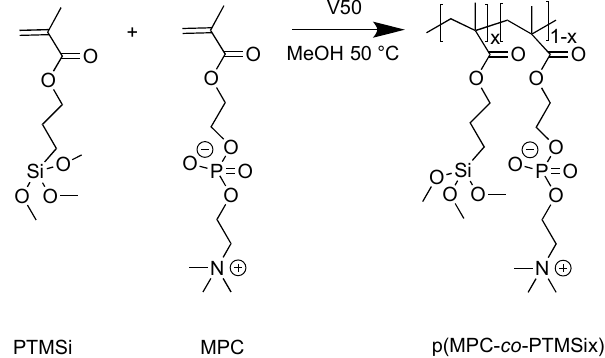
Figure 2. Synthesis of the zwitterionic copolymers based on hydrophilic MPC and PTMSi (x = 1, 5 mol%).